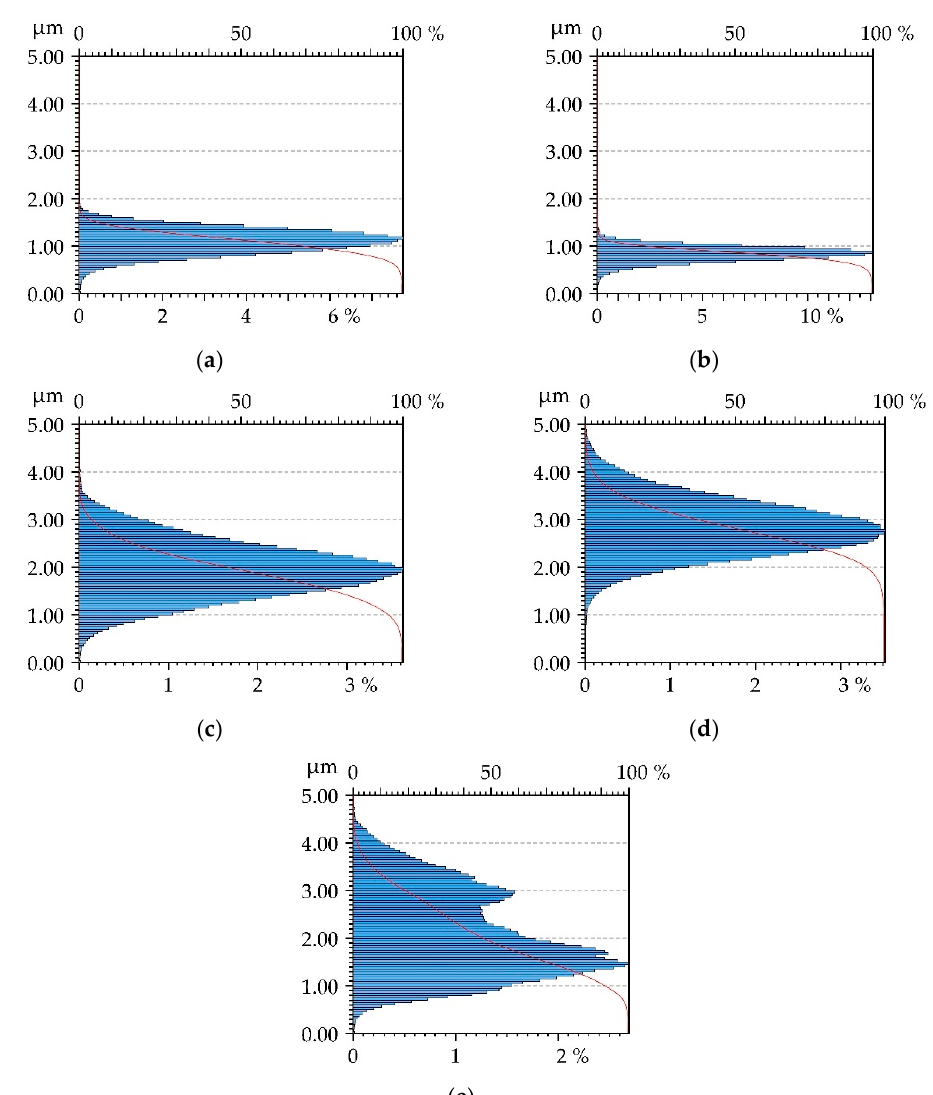
Figure 3. Material ratio curves and ordinate distributions of disc surfaces after burnishing with a pressure (P) of 10 MPa ( a ), 20 MPa ( b ), 30 MPa ( c ), 40 MPa ( d ) and after milling ( e ).